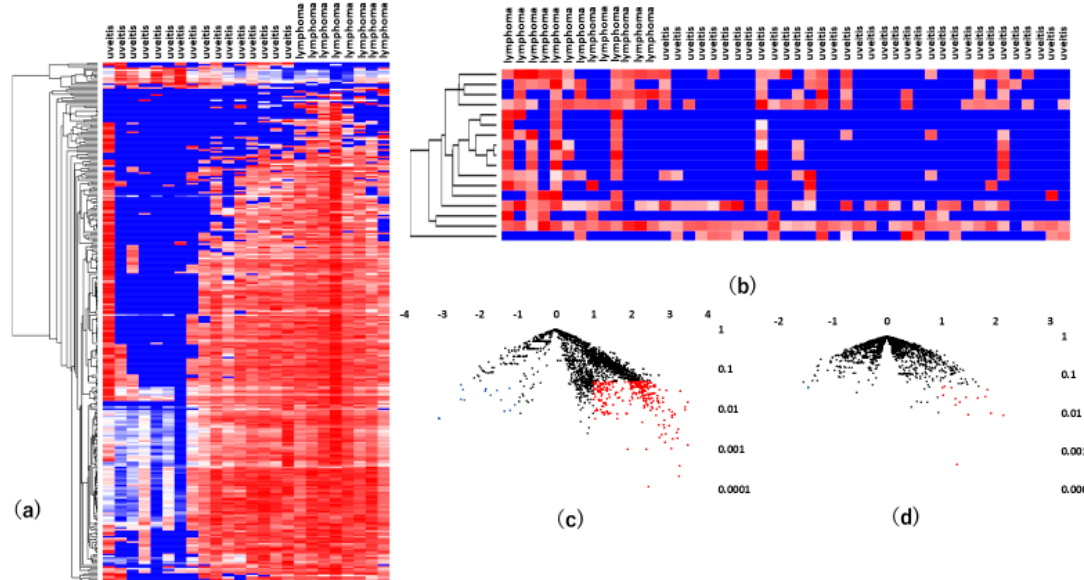
Figure 5. Results of analyses of differentially expressed vitreous and serum miRNAs in VRL patients versus uveitis with vitreous opacity. ( a ). vitreous, ( b ). serum unsupervised hierarchical clustering analysis with a heatmap. ( c ). vitreous, ( d ). serum volcano plot showing differentially expressed miRNAs in VRL versus uveitis. Blue dots indicate downregulation, red dots indicate upregulation of the miRNAs and black dots indicate no significant difference.